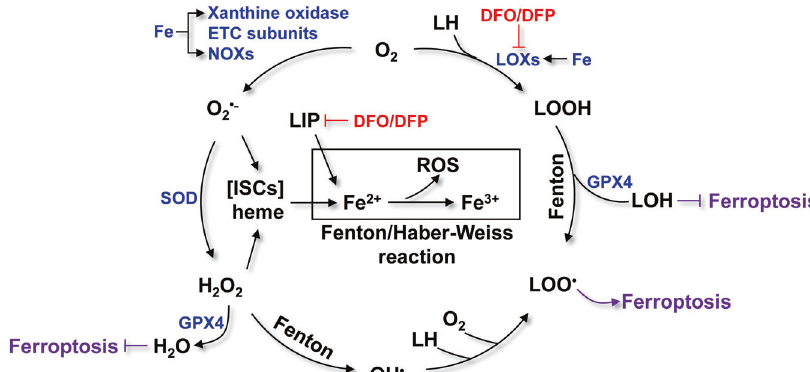
Fig. 4 Iron-driven ROS generation and lipid oxidation in ferroptosis. O 2 (cid:129) − is generated from iron-containing proteins, including xanthine oxidase, ETC subunits, and NOXs. O 2 (cid:129) − can be further converted to H 2 O 2 . Both O 2 (cid:129) − and H 2 O 2 attack ISCs and heme, leading to the release of Fe 2 + . The Fe 2 + -driven Fenton reaction generates OH (cid:129) , which can react with LH to generate LOO (cid:129) . Meanwhile, LH can be oxidized by LOXs to produce LOOH, which can be further converted into LOO (cid:129) by the Fenton reaction. Finally, LOO (cid:129) induces ferroptosis. Ferroptosis can be inhibited by iron chelators (e.g., DFO and DFP) and